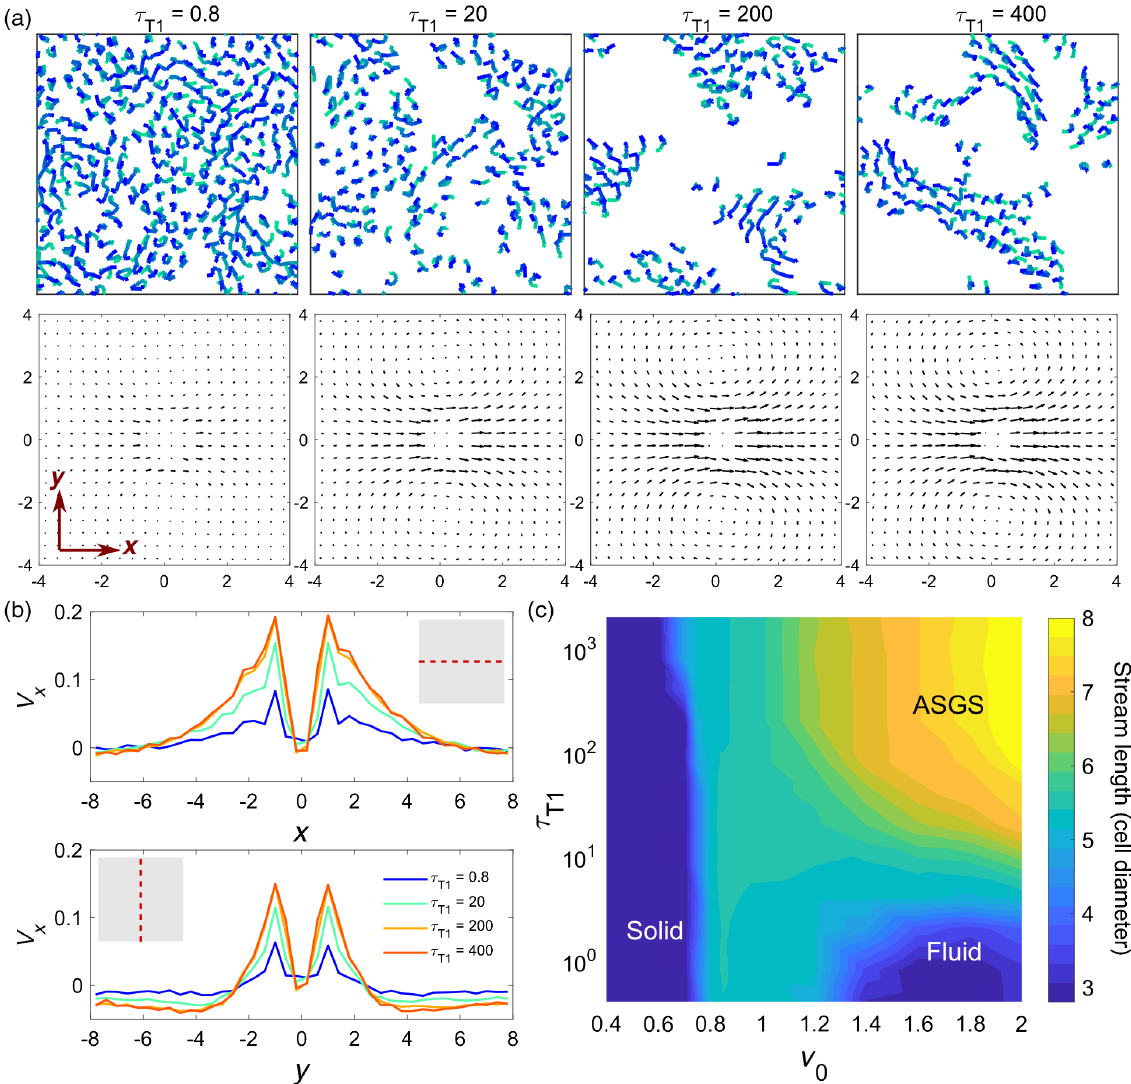
FIG. 5. Visualization and characterization of cell streaming. (a) The individual cell trajectories at different τ Top row: cell trajectories for a short time period. Colors change from green to blue to mark cell positions progressively forward in time. Trajectories are shown only for the cells that travel 80% of average cell diameter or more distance in this time window. Bottom row: ⃗ V average velocity field around any cell corresponding to each panel in the top row. Here, the reference cell is always at the origin, its velocity vector pointing from left to right. (b) Correlation of cell motions is shown by plots of V x , the x component of parallel to the x axis (top) and the y axis (bottom), respectively. These two lines are also illustrated as dotted lines in the insets. (c) The typical length of cell streams, estimated from the plot of V x along the x axis [top in (b)], shown as a color map as a function of v 0 and τ Here, we define the length or width of the stream, as we move away either along the x or y direction from the origin, respectively, to be the distance between the points where V x falls off below a fixed value V (cid:3) x ¼ 0 . 05 , suitably chosen to calculate the stream sizes. The color map of stream lengths varies significantly across the three phases as encountered in Fig. 3, while the stream widths vary very little between three and four average cell